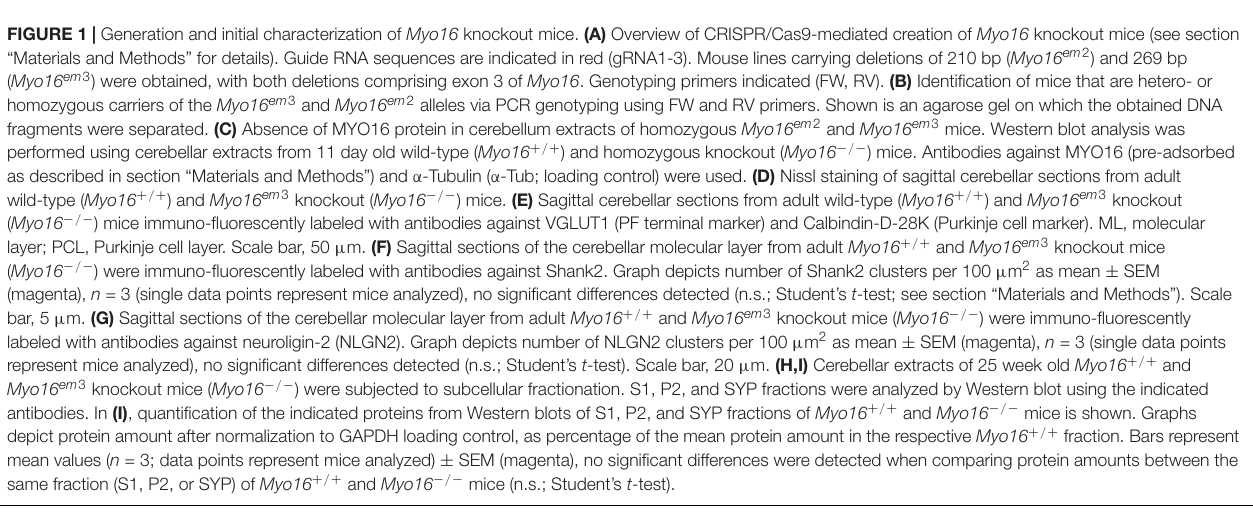
Frontiers in Cellular Neuroscience |